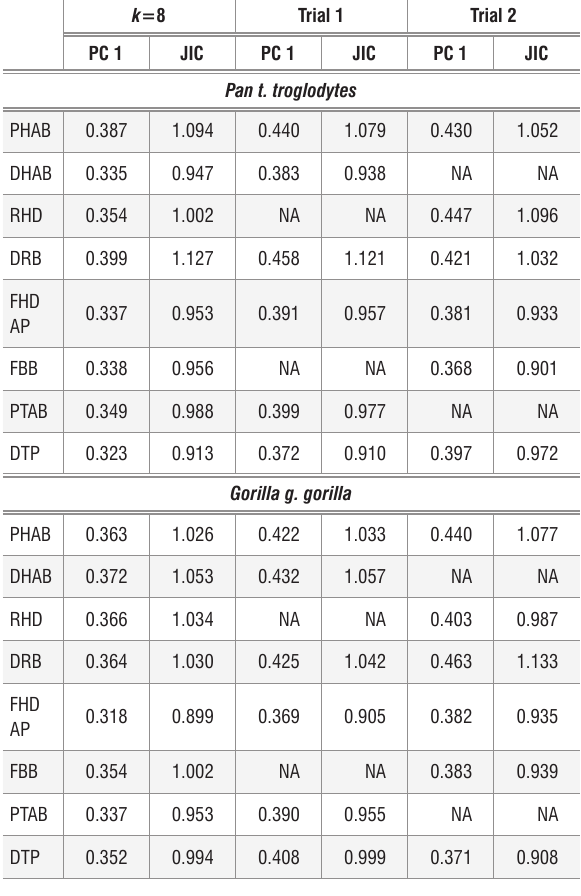
Summary statistics for the principal components (PC) analysis (trial redundancies)